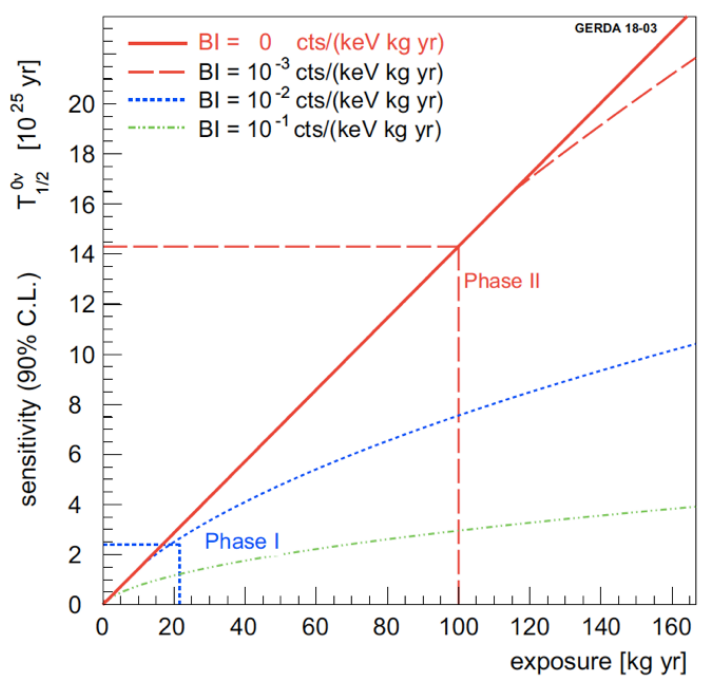
Figure 3. The G ERDA design sensitivity on 76 Ge T 0 ν BI